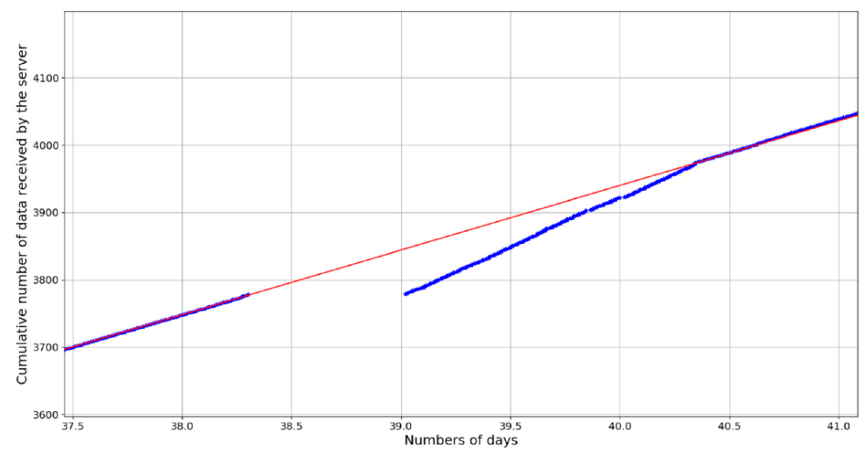
Figure 7. Cumulative number of data frames received by the LoRa server (from a Mt. Barbagallo node)